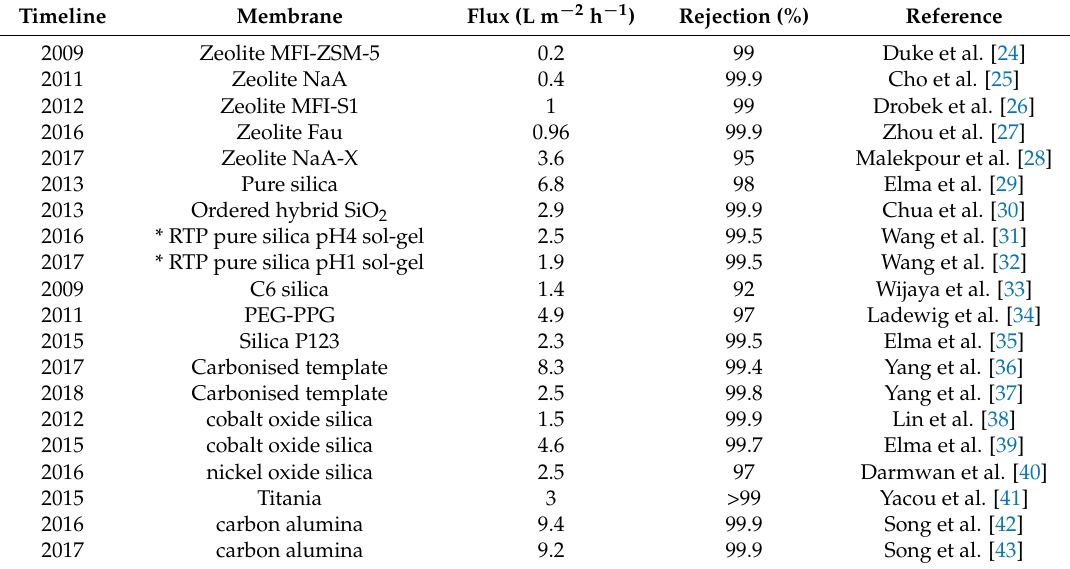
* RTP—Rapid Thermal